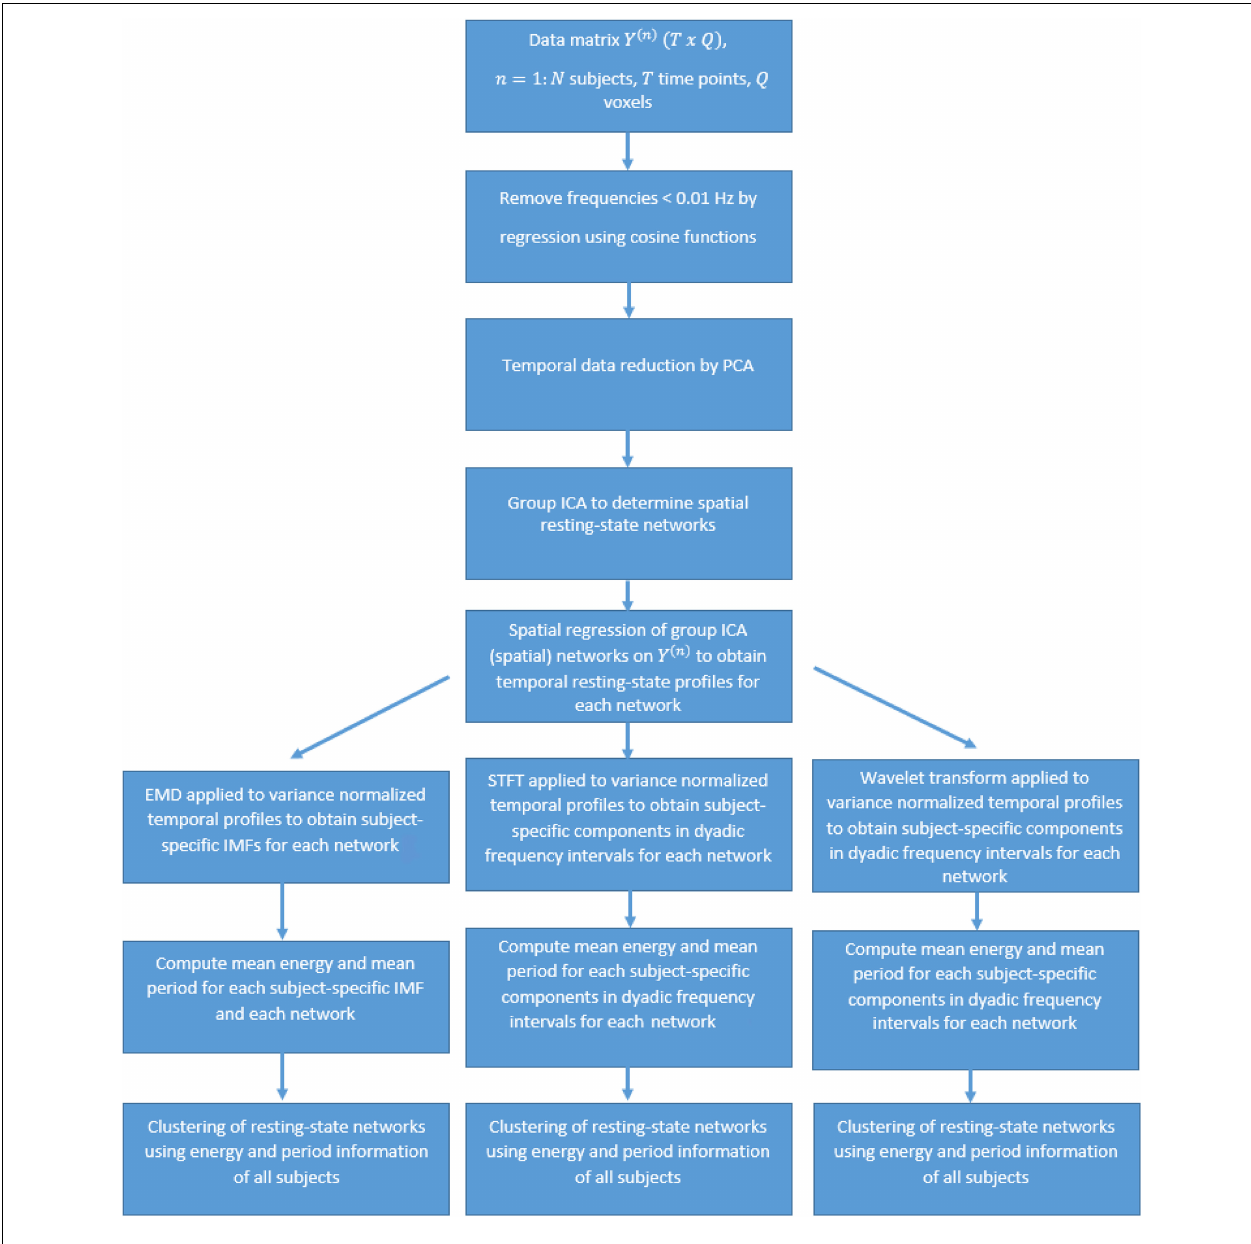
FIGURE 1 | Flow chart of the data